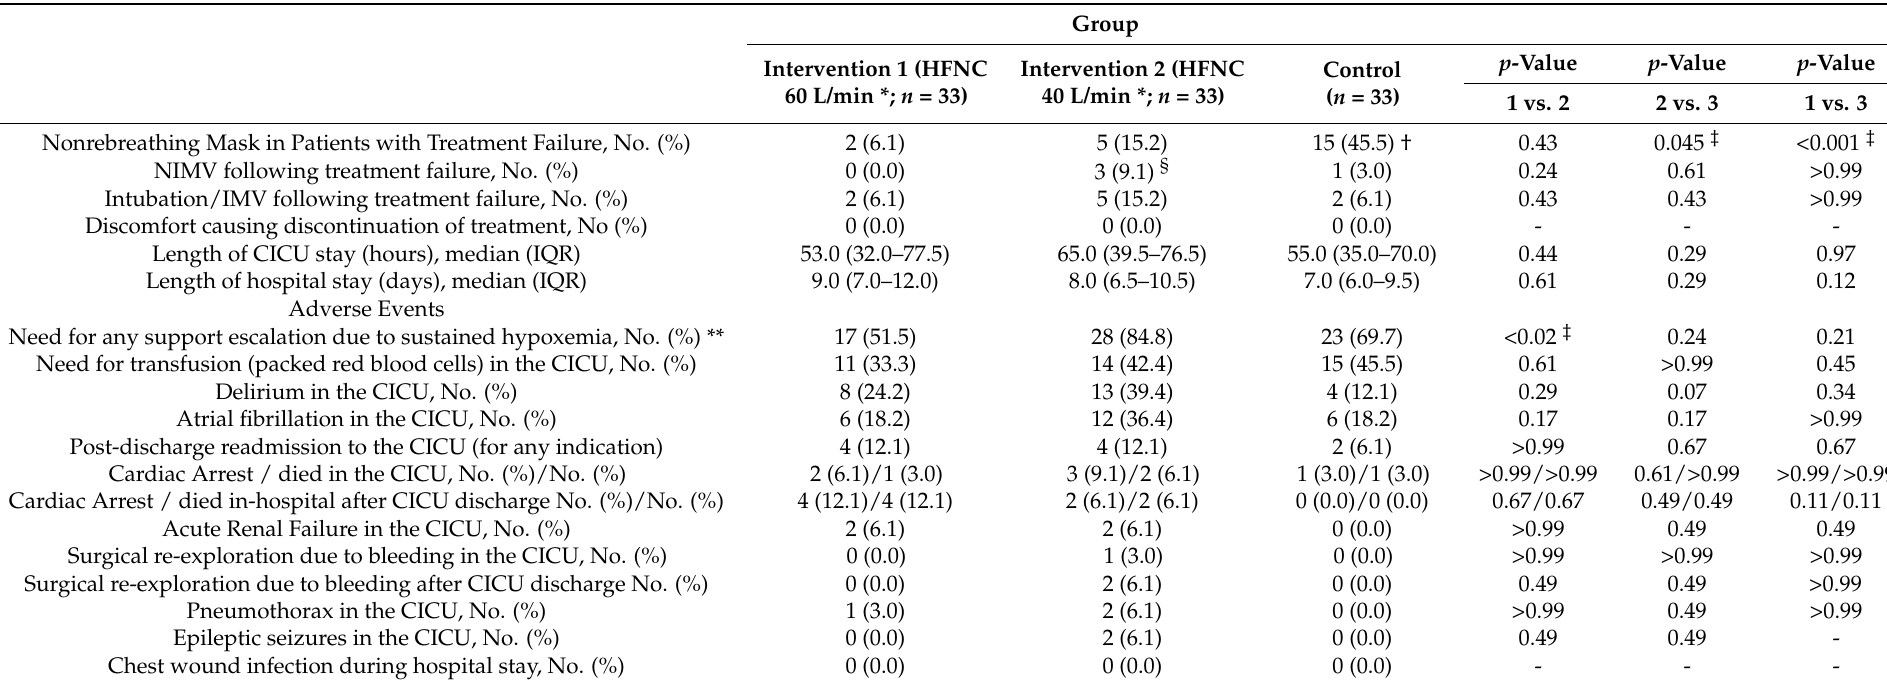
Table 5. Management of treatment failure, “other” prespecified outcomes, and adverse events. Group Intervention 1 (HFNC Intervention 2 (HFNC Control p -Value p -Value 60 L/min *; n = 33) 40 L/min *; n = 33)